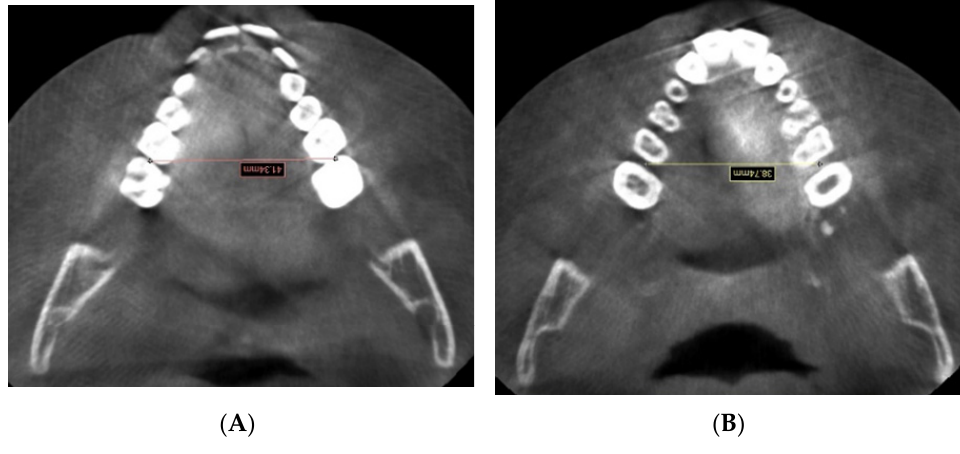
Figure 3. ( A ) 6RIM-6LIM measure; ( B ) 6RABM-6LABM.